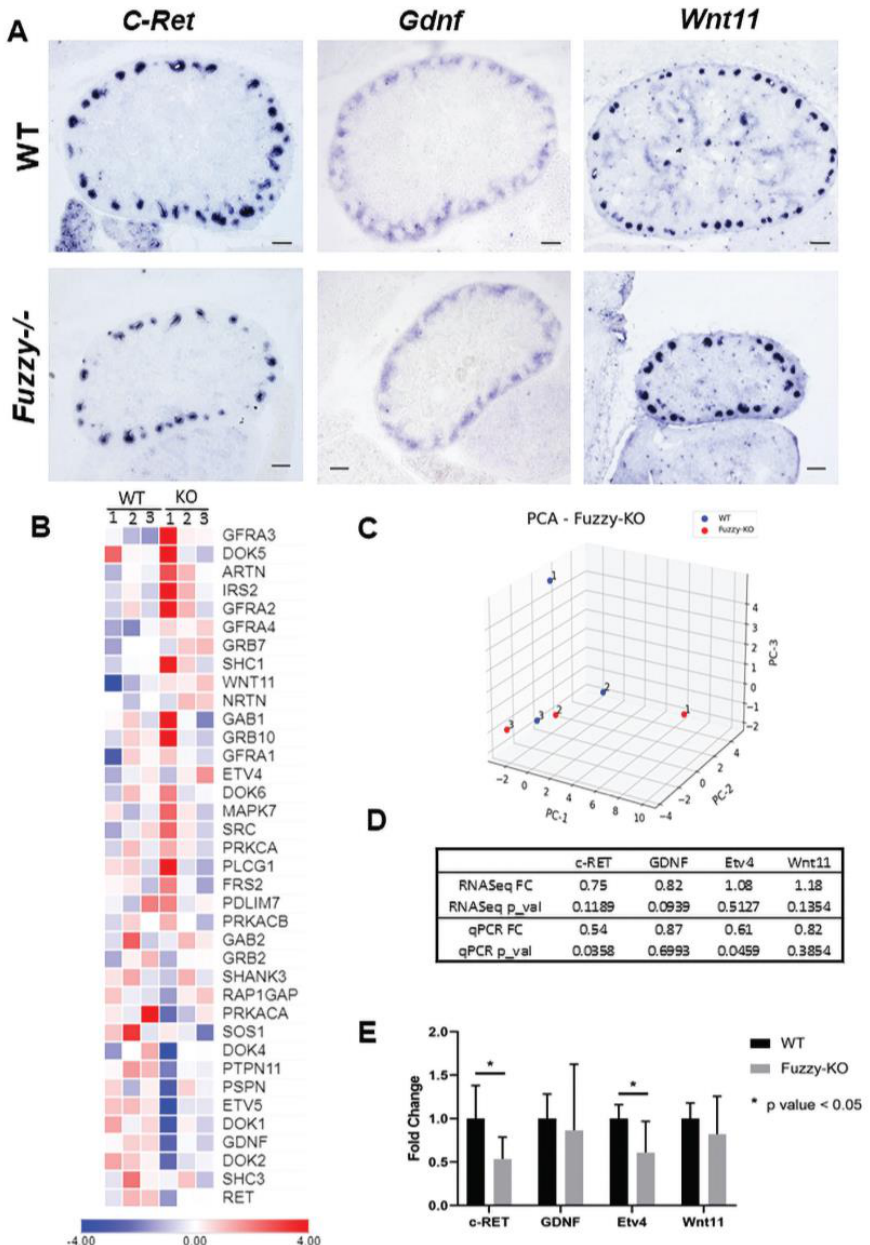
Figure 4. Gdnf/c-Ret signaling in E14.5. Fuzzy − / − embryonic kidneys. ( A ) In situ